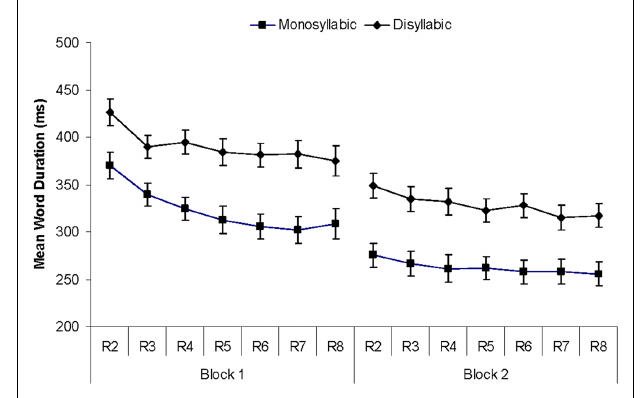
FIGURE 3 | Results of Experiment 1. Mean word durations (ms) per block and repetition (R2 through R8) for monosyllabic and disyllabic items.